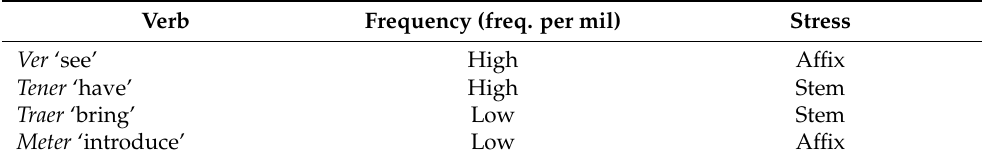
Table 2. Experimental verbs.